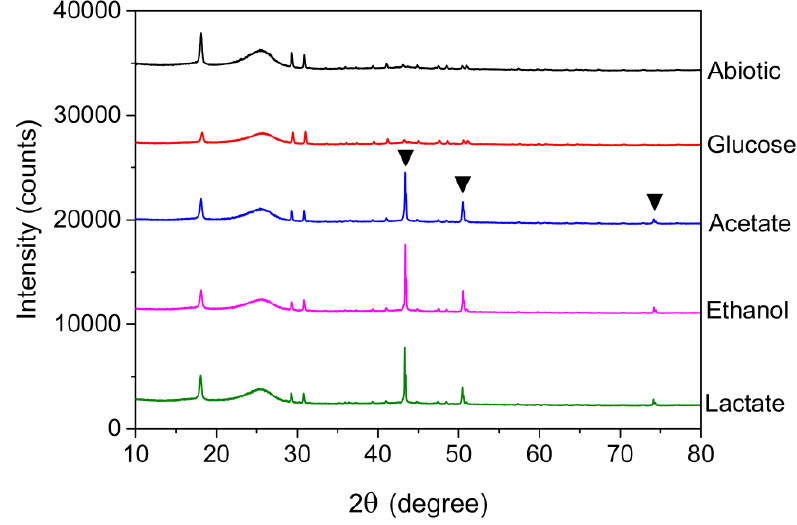
Figure 10. XRD analysis of the cathodes of MFCs after the treatment of simulated AMD ( ▼ indicates characteristic peaks of Cu 0 ).